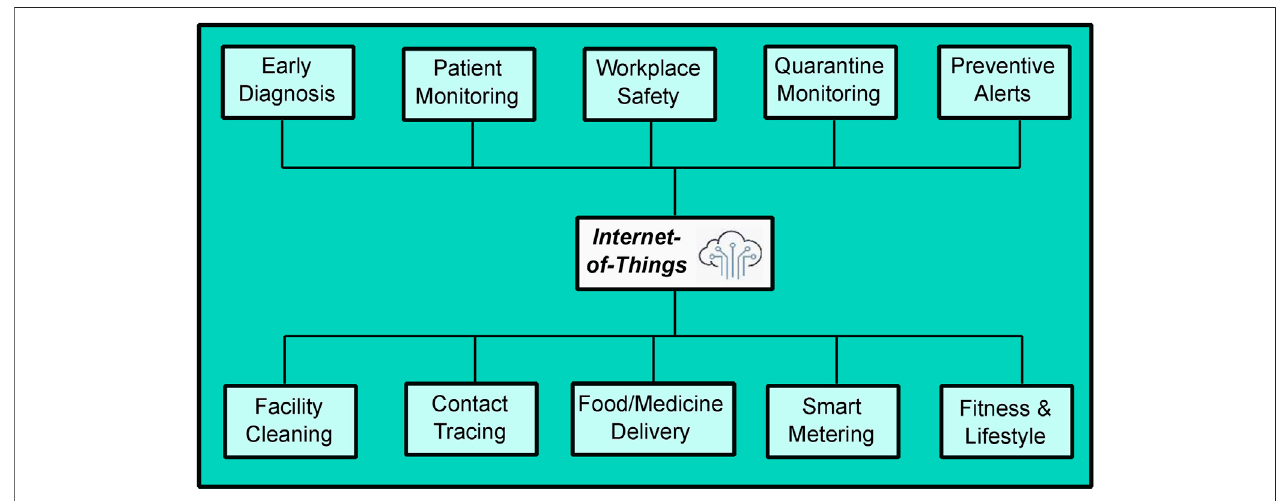
FIGURE 1 | Applications of IoT for COVID-19 pandemic impact